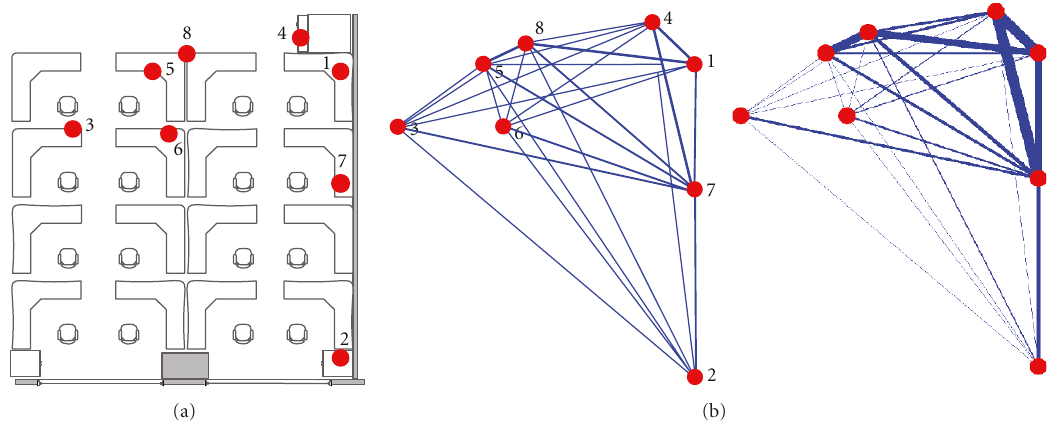
Figure 24: The experiment scenario and link qualities of CTP.